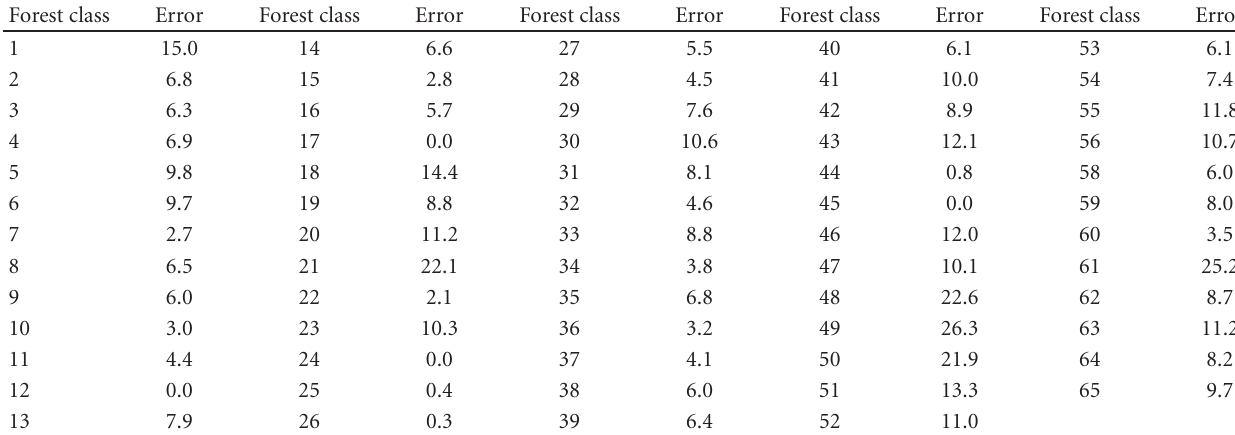
Table 2: Error in area weighted estimates of forest carbon density within forest classes containing measured eucalypt forests between Inventory areas (Standard error of the mean as a percentage of the mean).